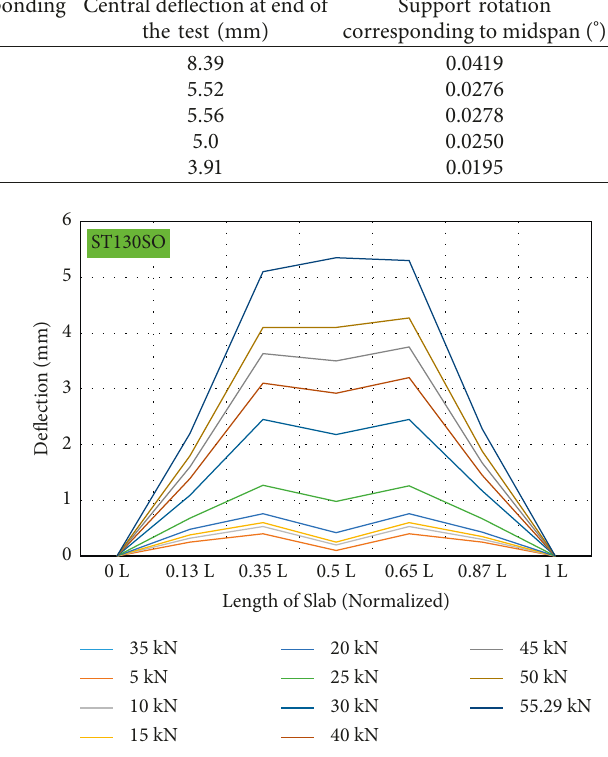
Figure 8: Deflection profile of slab ST100SO. Figure 9: Deflection profile of slab ST130SO.